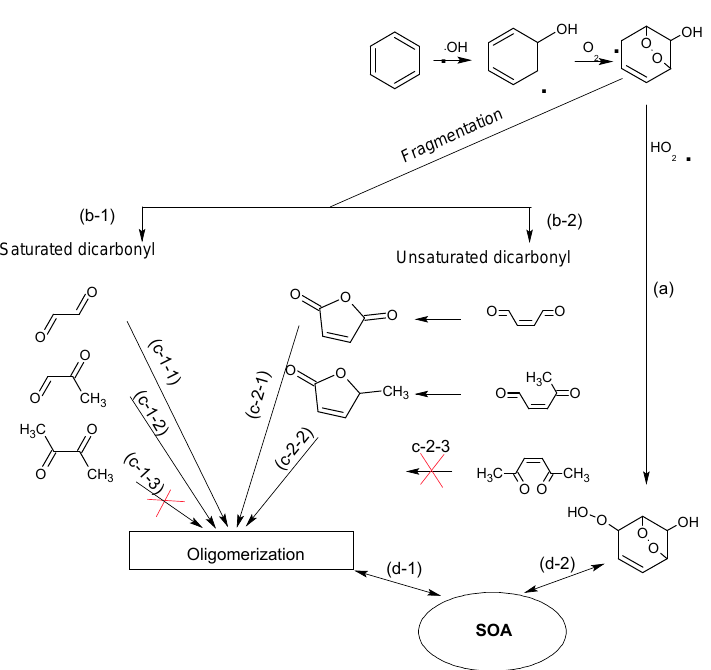
Figure 7. Monocyclic aromatic hydrocarbon oxidation pathways related to SOA formation (methyl substitute on aromatic ring not shown).